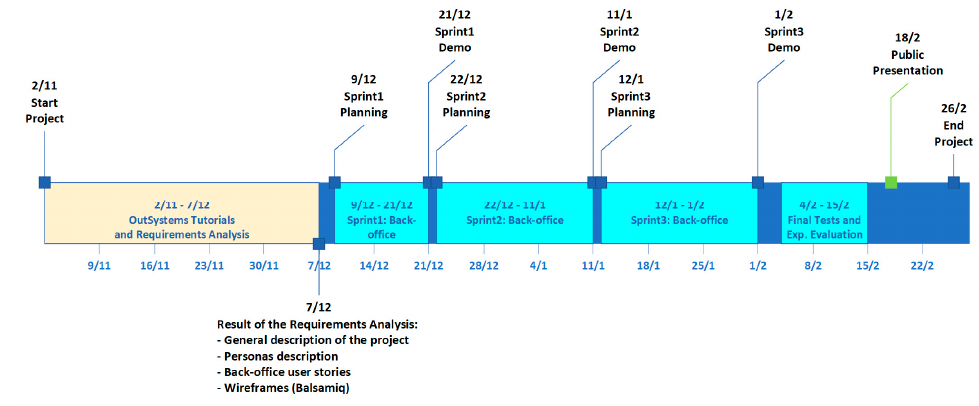
Figure 6. Timeline (first semester).